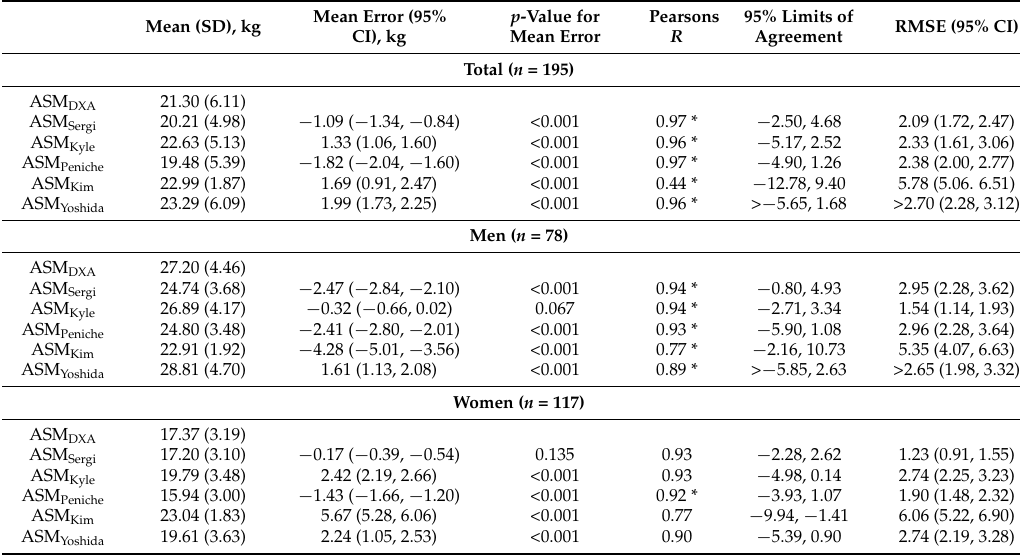
<0.001 0.90 ´ 5.39,